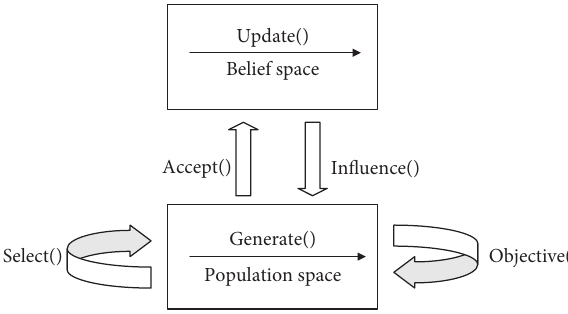
Figure 15: Graphical representation of the cultural